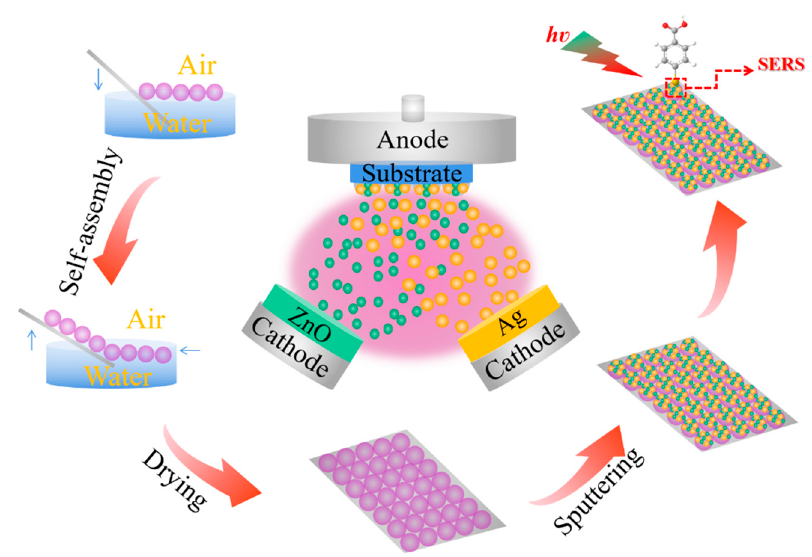
Scheme 1. Schematic showing the fabrication process of the Ag/ZnO ordered